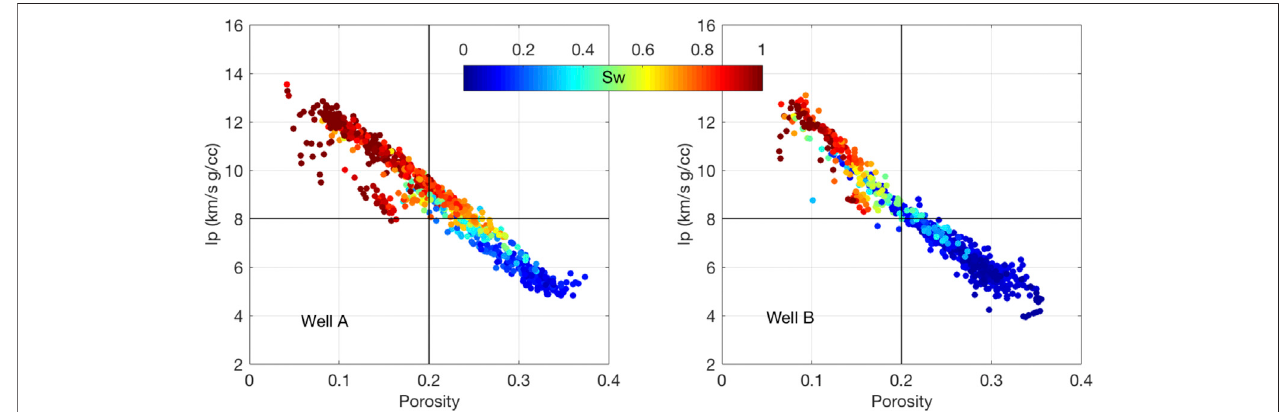
FIGURE 4 | Cross-plots of I p as measured vs. porosity color-coded by water saturation for Wells A and B.